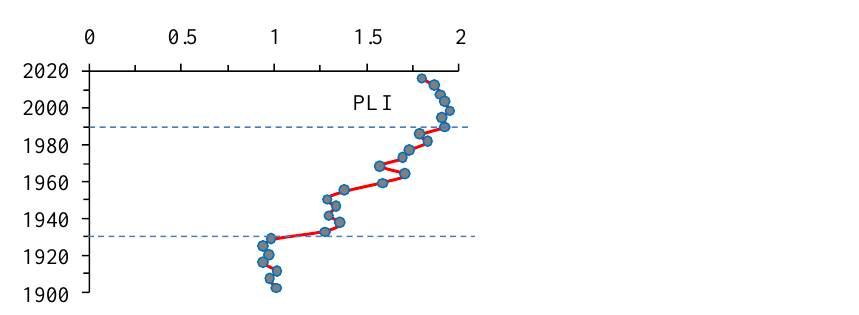
Figure 14. Distribution of Pollution Load Index (PLI) value in the sediment core of Lake Bolshoy Vudjavr.